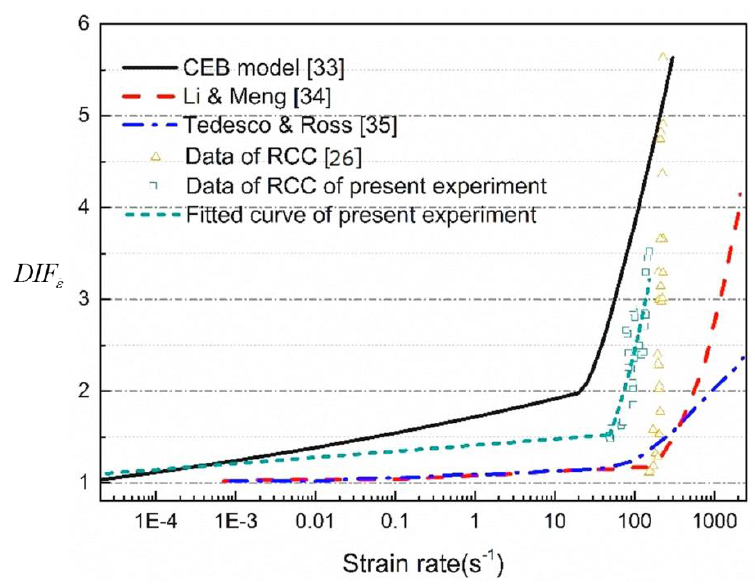
Figure 6. The true compressive strength DIF of RCC material.